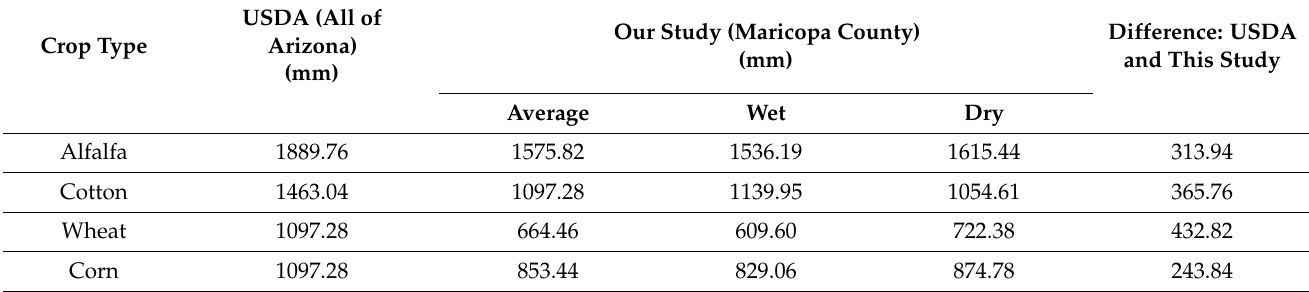
Table 3. Comparison of water application rates in USDA survey with ET rates. (Source: USDA data were taken from Farm and Irrigation Survey for Arizona (USDA,